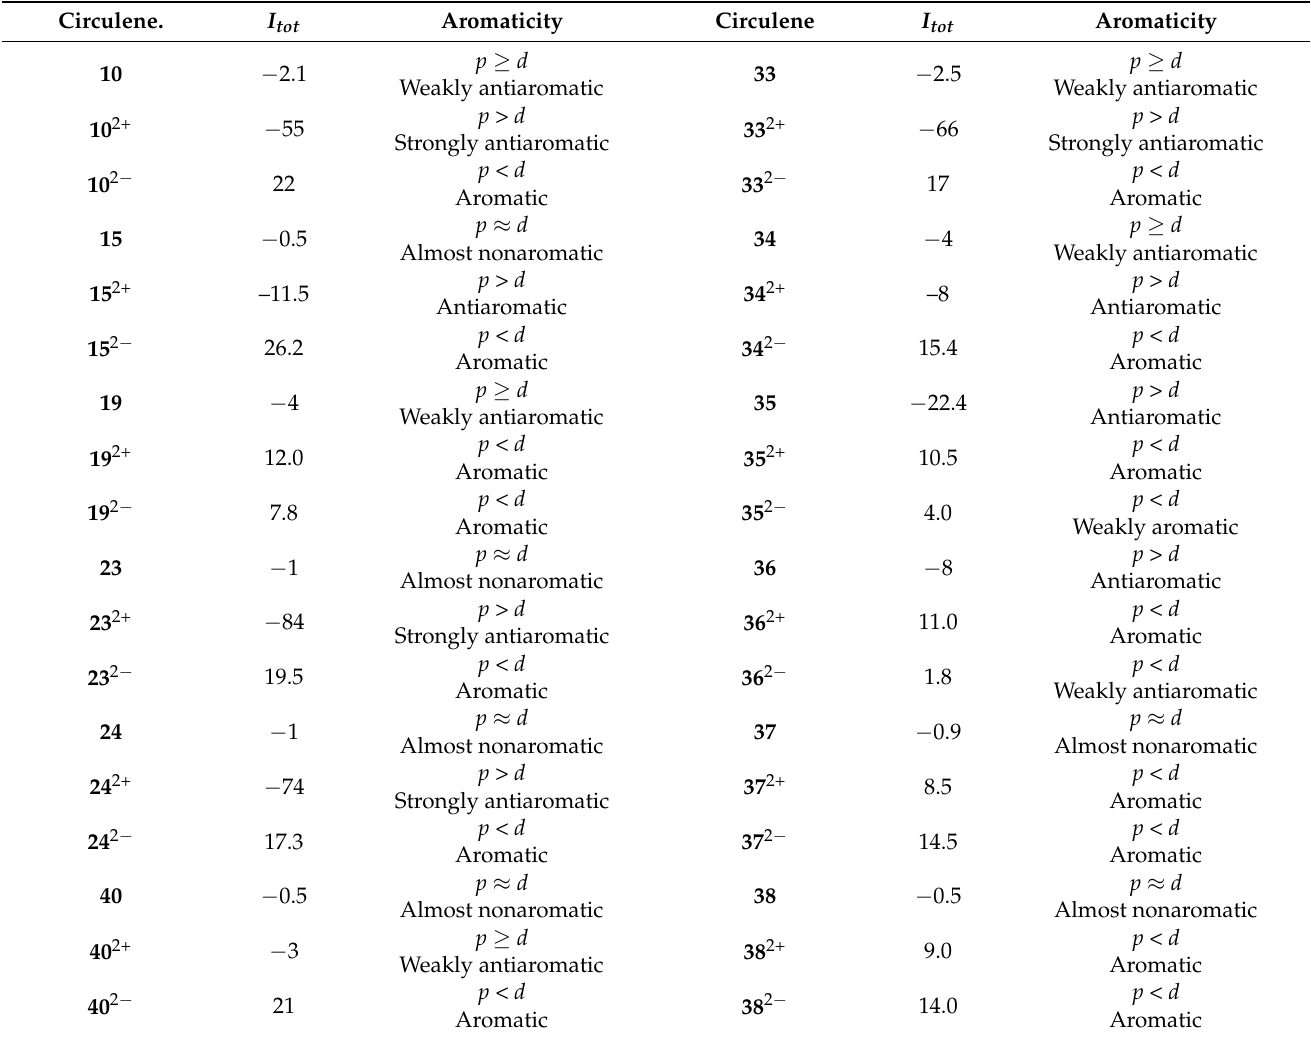
Table 3. The total ring current strength ( I tot , nA · T − 1 ) and the balance between the diatropic ( d ) and paratropic ( p ) currents in the rim - and hub -subsystems for the neutrally and doubly charged hetero[8]circulene molecules.